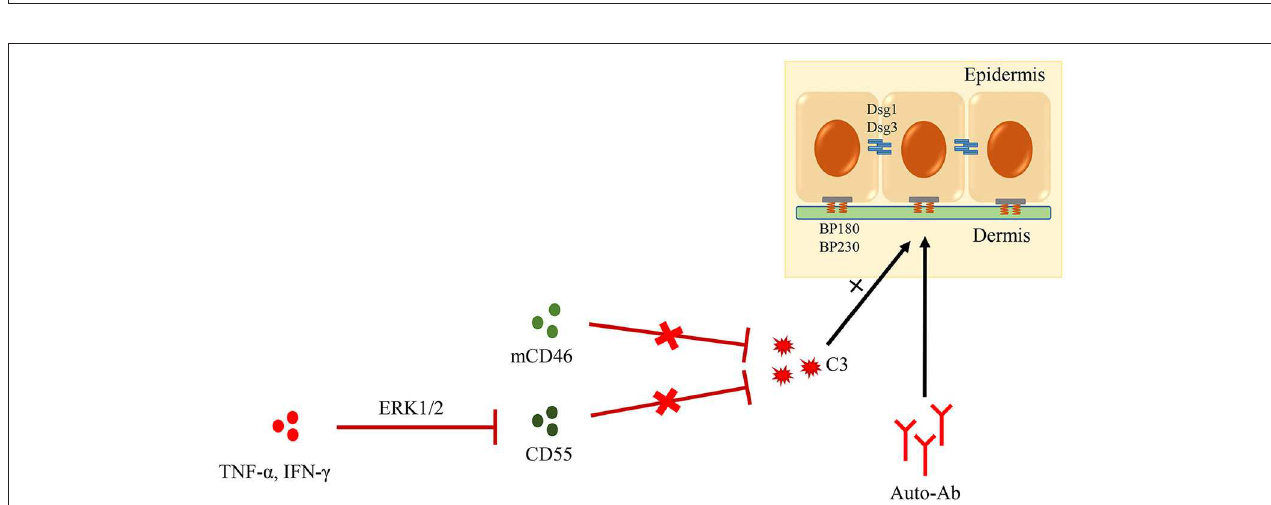
FIGURE 4 | Role of CRPs in AIBD. Complement activation is one of the pivotal steps in BP development. mCD46 and CD55, two important CRPs, could inhibit autoantibody-mediated complement activation. Additionally, CD55 is down-regulated by TNF- α and IFN- γ though ERK1/2 signaling pathway in BP